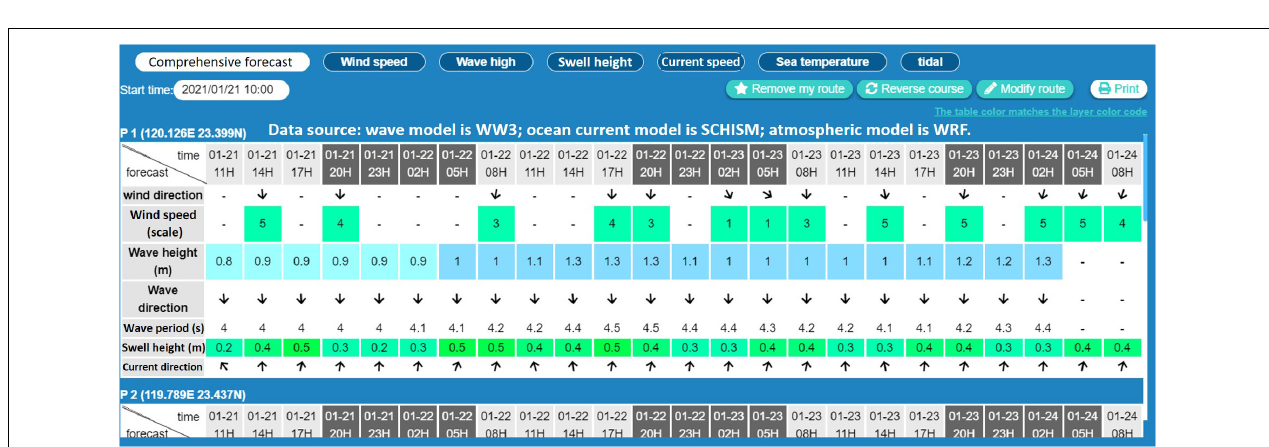
FIGURE 3 | Snapshot of using the service for self-defined cruise sea states in the TwMEMS Safe Sea function.